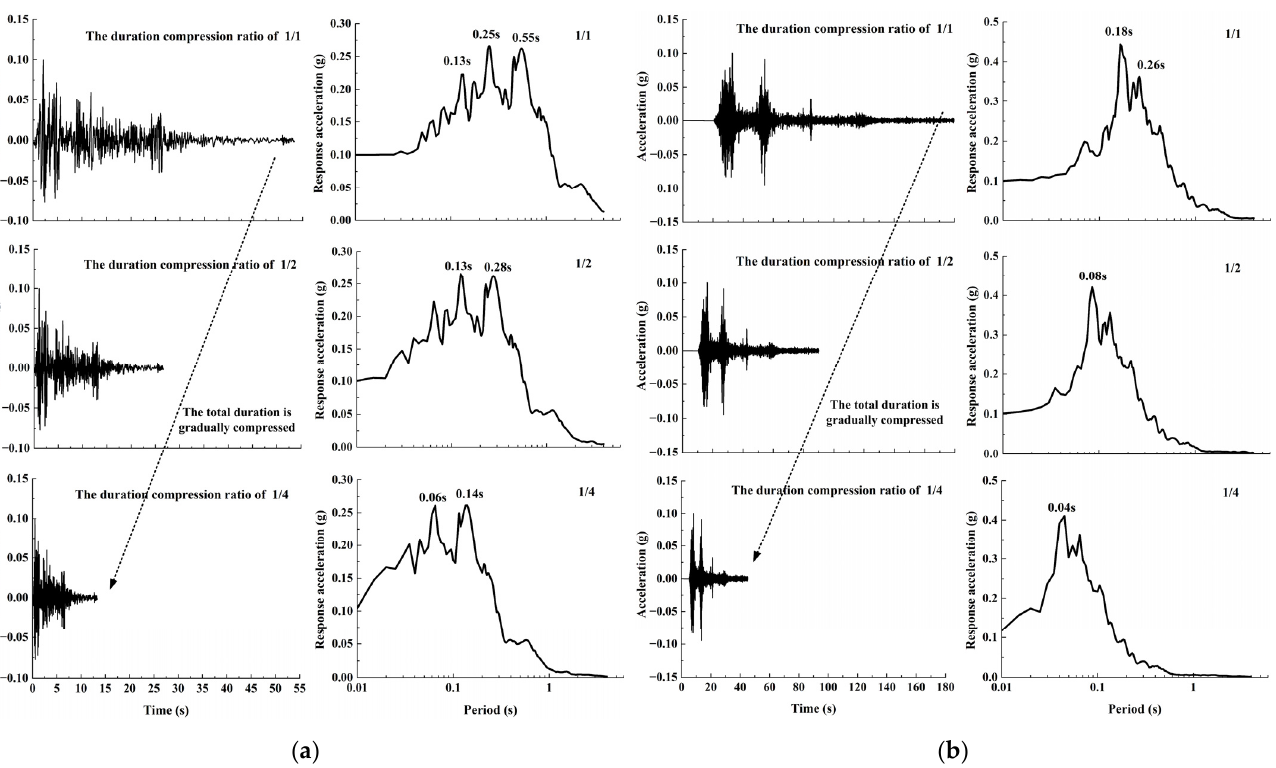
Table 2. Experimental loading scheme. Test ID